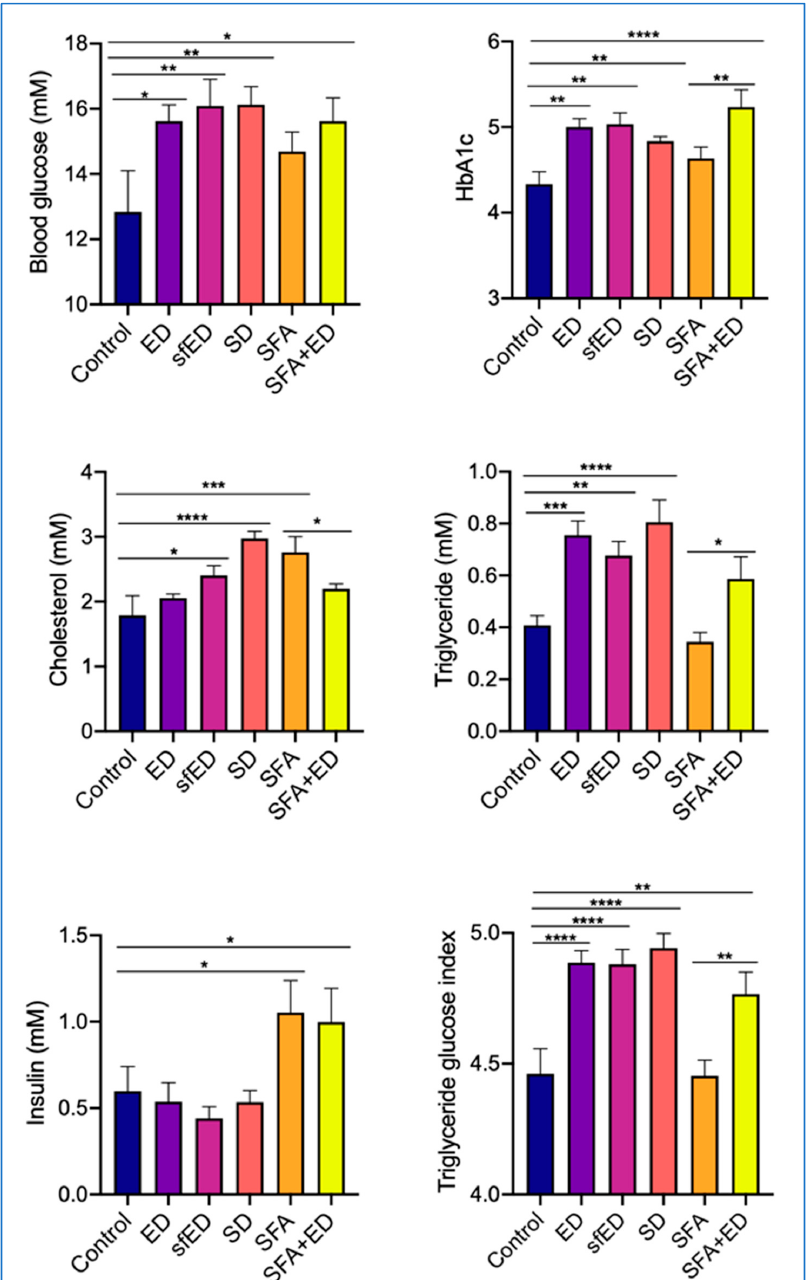
Figure 4. Blood glucose, lipids and insulin measurements. The mice received no liquid intervention (Control), Mother (ED), sugar-free Mother (sfED), Coca-Cola (SD), saturated fat enriched diet (SFA) or SFA with ED (SFA + ED) for 13 weeks. Blood glucose and HbA1c were measured at sacrifice with point-of-care device. Serum cholesterol and triglycerides were measured with colorimetric assay. Insulin was measured with a commercial ELISA kit. Triglyceride glucose index was calculated based on previous studies. Statistical analysis was performed using a one-way ANOVA with Fisher’s LSD post hoc analysis ( n = 10; * p < 0.05, ** p < 0.005, *** p < 0.0005, **** p < 0.0001).